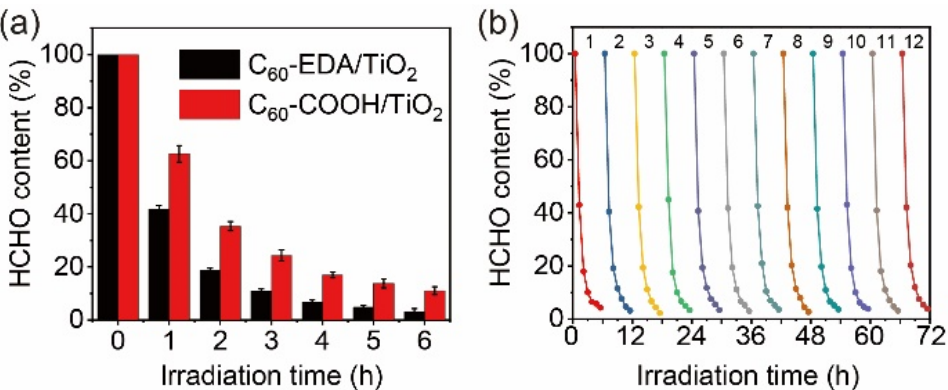
Figure 3. ( a ) Catalytic performance of C 60 -EDA/TiO 2 and C 60 -COOH/TiO 2 for the photodegradation of HCHO under simulated sunlight irradiation. ( b ) Cycling tests of C 60 -EDA/TiO 2 for 12 cycles of photodegradation.